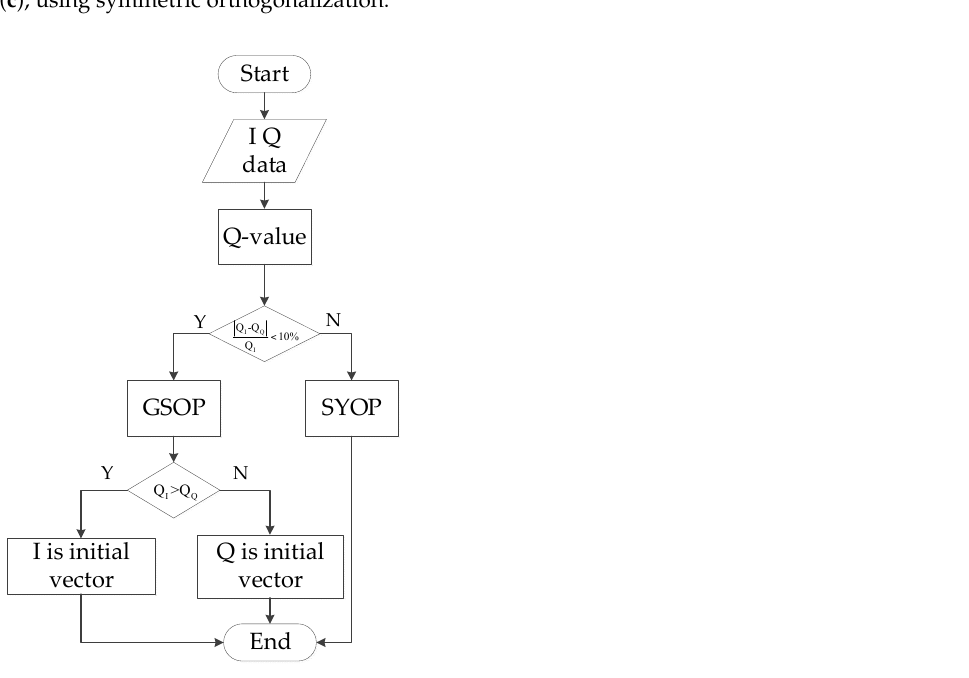
Figure 4. Flow chart of the algorithm switching orthogonalization procedure (ASOP) algorithm.